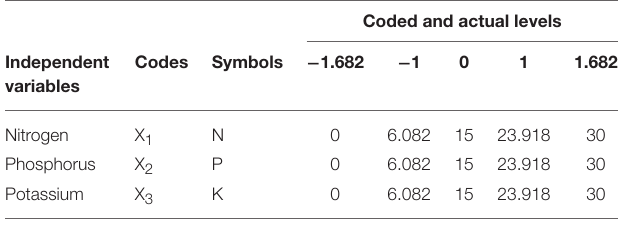
TABLE 2 | Experimental design and layout of treatment combinations in the central composite rotatable design. Coded and actual levels Treatments Coded values